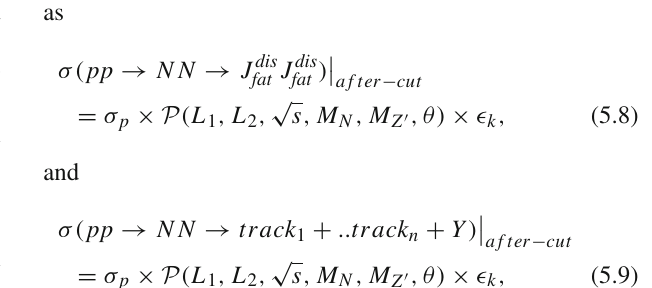
the number of events, we implement both the geometric and kinematic cuts, the details of which are provided in Sects.